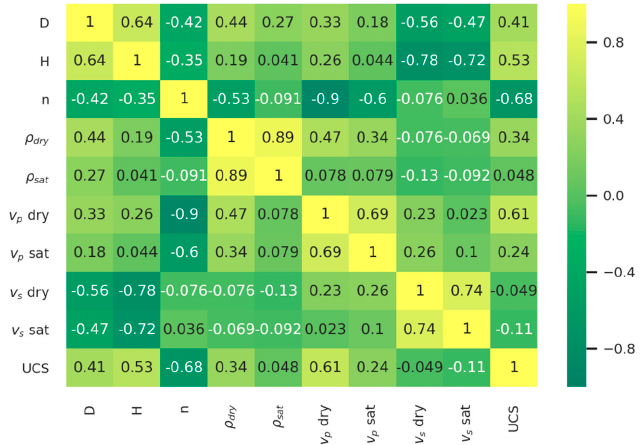
Figure 3. Correlation plot of sampled variables.